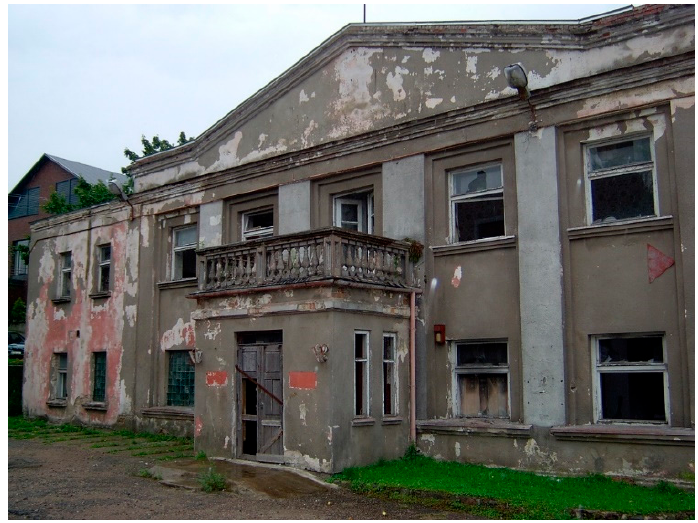
Figure 4. Plung ė synagogue, 2007. Photo Vilma Gradinskaite. Figure 4. Plung˙e synagogue, 2007. Photo Vilma